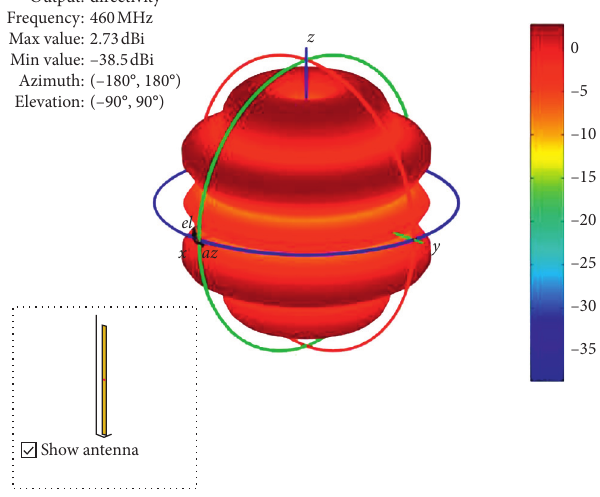
Figure 7: Dipole’s radiation pattern and phase at